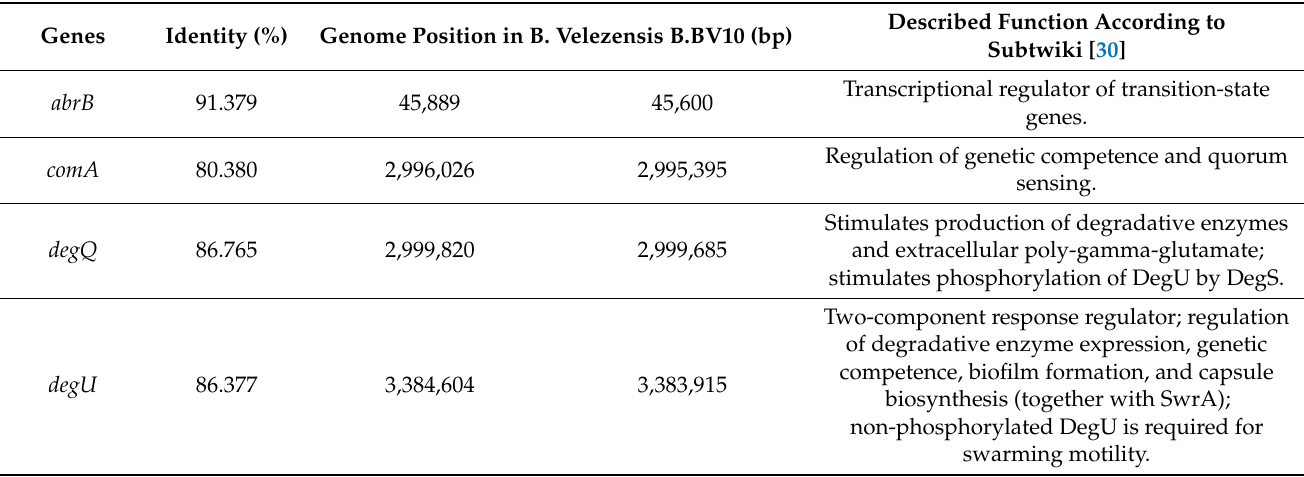
Table 5. Colonization-related